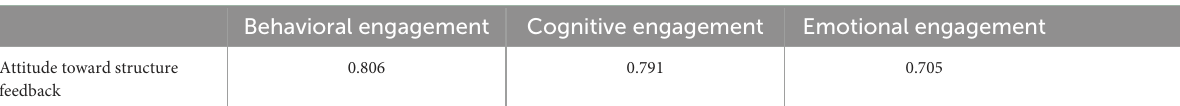
FIGURE3 Final research model results.